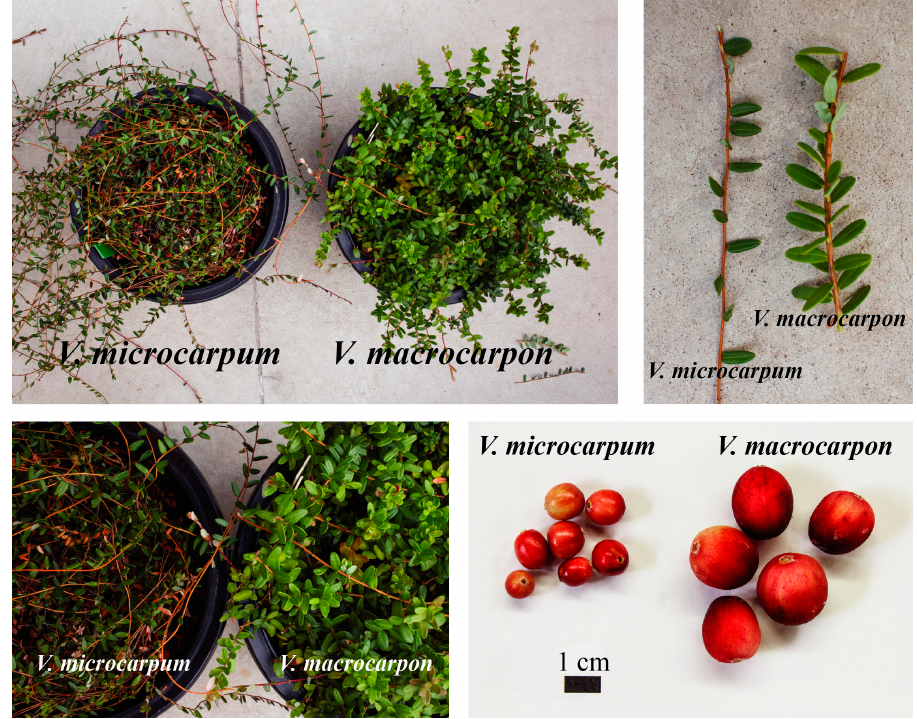
Figure 1. Distinctive characteristics of plant architecture and fruit of V. microcarpum and V. macrocarpon “Stevens” plants.